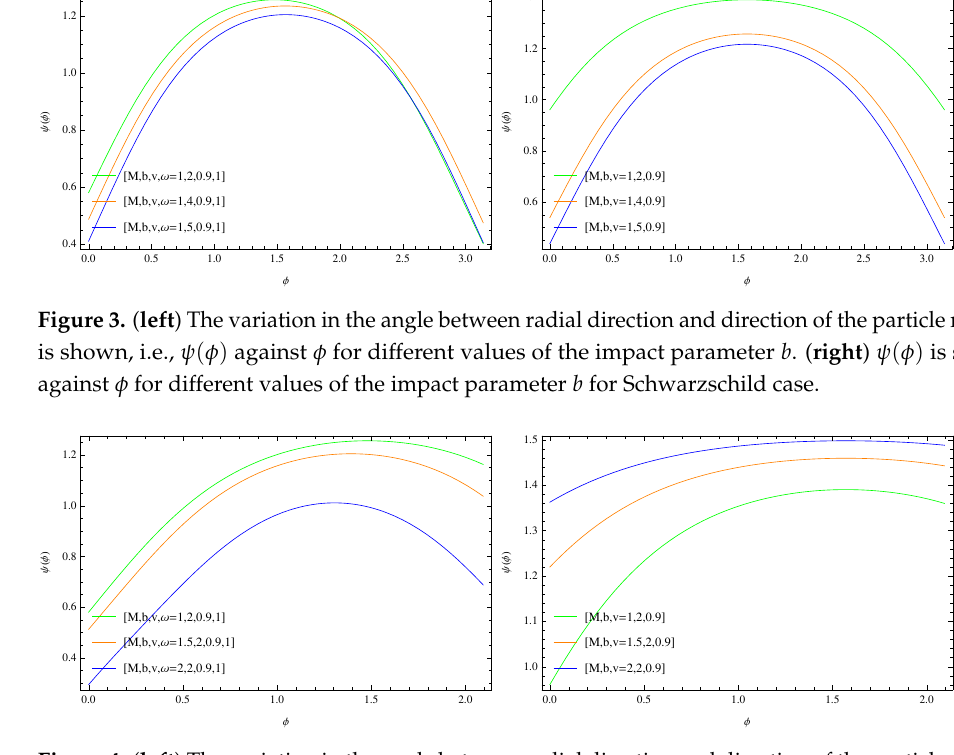
Figure 4. ( left ) The variation in the angle between radial direction and direction of the particle motion is shown, i.e., ψ ( φ ) is shown against φ for different values of M of the gravitating body. ( right ) ψ ( φ ) is shown against φ for different values of M of the gravitating body, for Schwarzschild